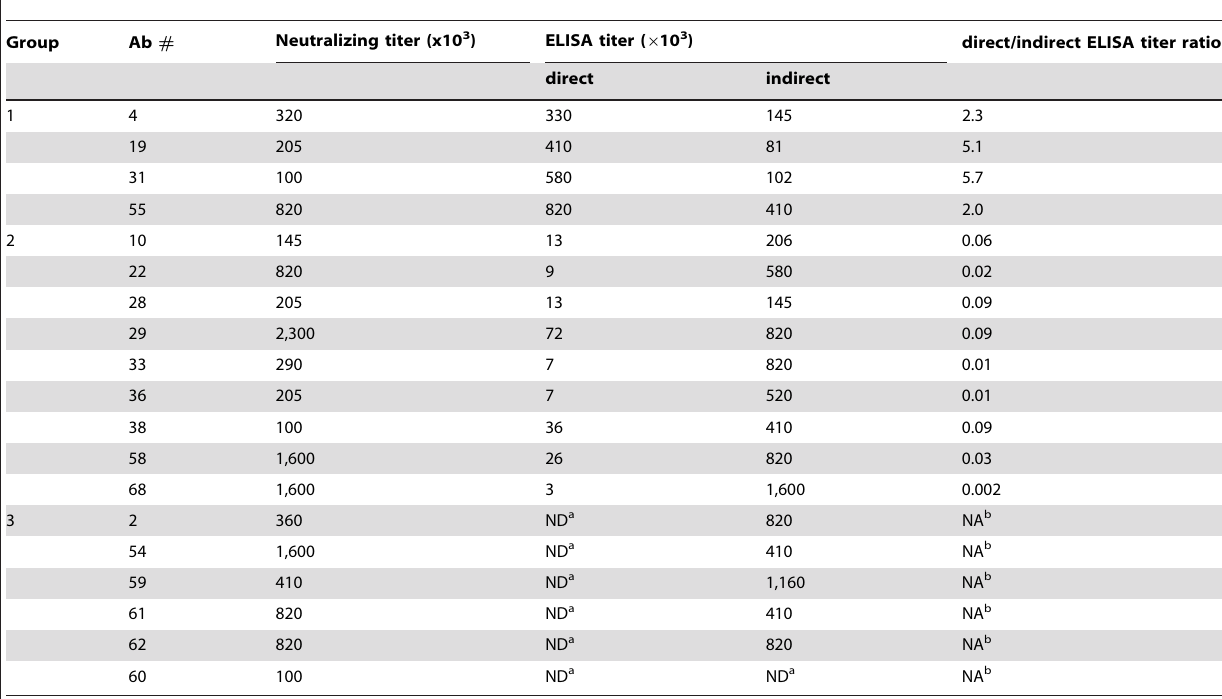
a ELISA titer values were below detection limits. b Not